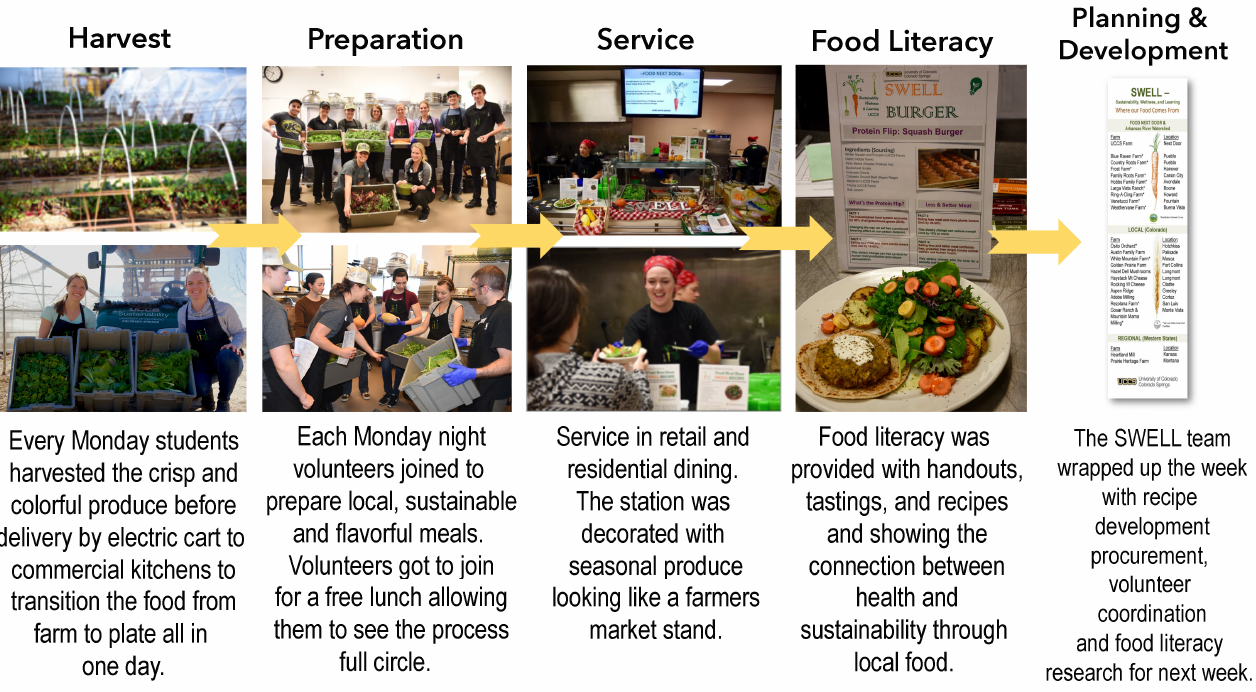
Figure 1. Food Next Door values for sustainable sourcing, adapted from Meyer, 2020 [35] with permission.